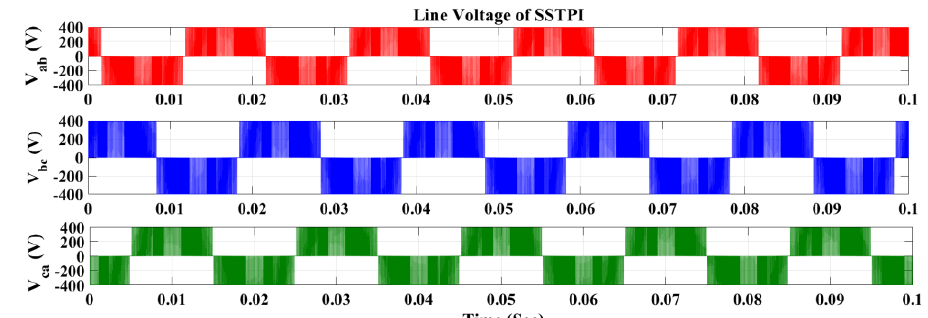
Figure 13. Output line voltages of SSTPI